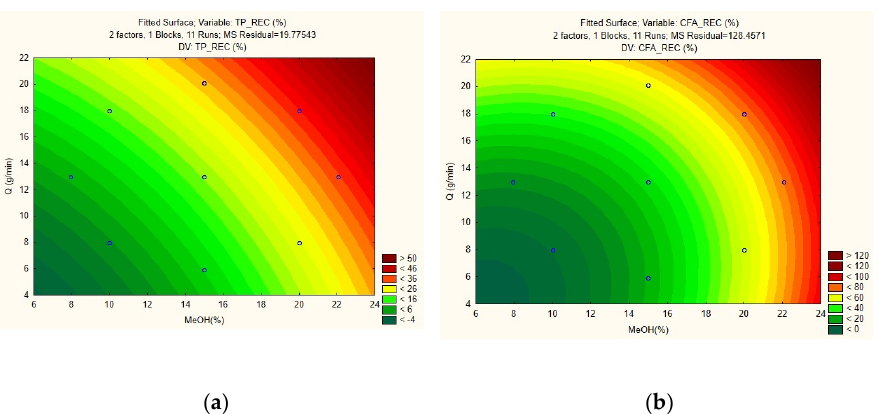
Figure 2. Response surfaces of MeOH % vs. q CO 2 of the models generated for ( a ) TPR and ( b ) CFA recovery of potato peels by SFE. recovery of potato peels by